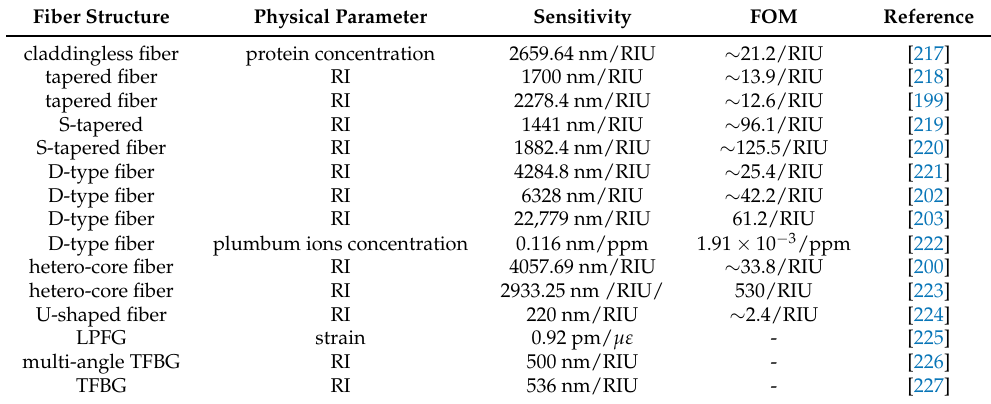
Table 2. Performance of optical fiber-SPR